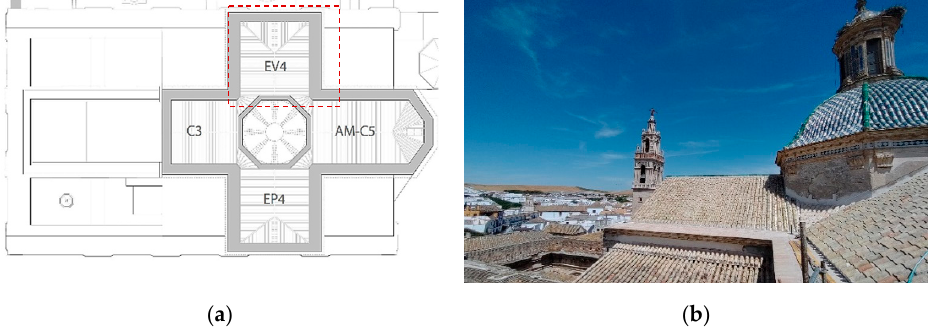
Figure 8. ( a ) Diagrams of roof sectors: EV4 (in red) is the structure under study; ( b ) view of the roof sectors; EP4 on the right and C3 in the centre.